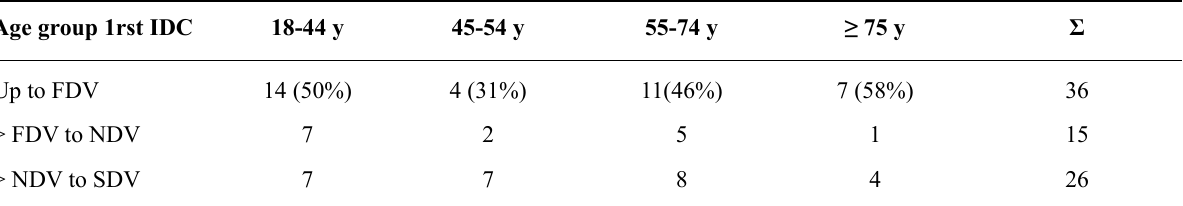
Table 6 - Recorded sensation on UDS at occurrence of the first IDC in the PDO group (FDV: first desire to void; NDV: normal desire to void; SDV: strong desire to void). The first IDC occurs significantly before or at the first desire to void (FDV) (p =